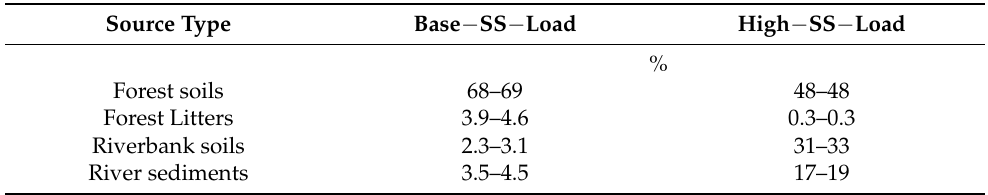
Table 3. Relative contributions of TSS sources (%) to bulk TSS under both the base- and high-SS-load conditions estimated by SIAR. The range indicates the 95% credible interval